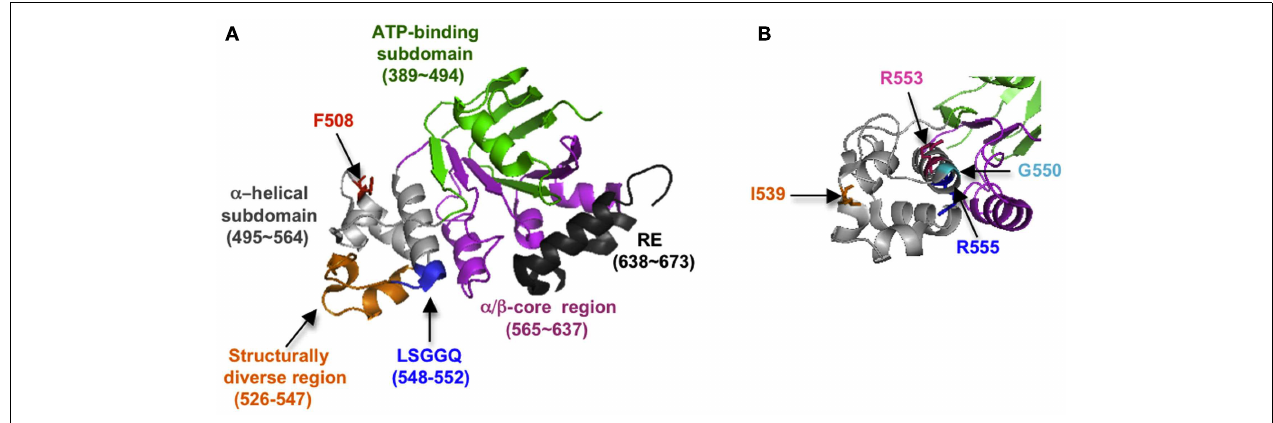
FIGURE 3 | (A) Crystal structure of NBD1 showing subdomain organization and location of key structural elements (2BBO). (B) Slightly different view of (A) , showing location of suppressor mutations (1XMI).